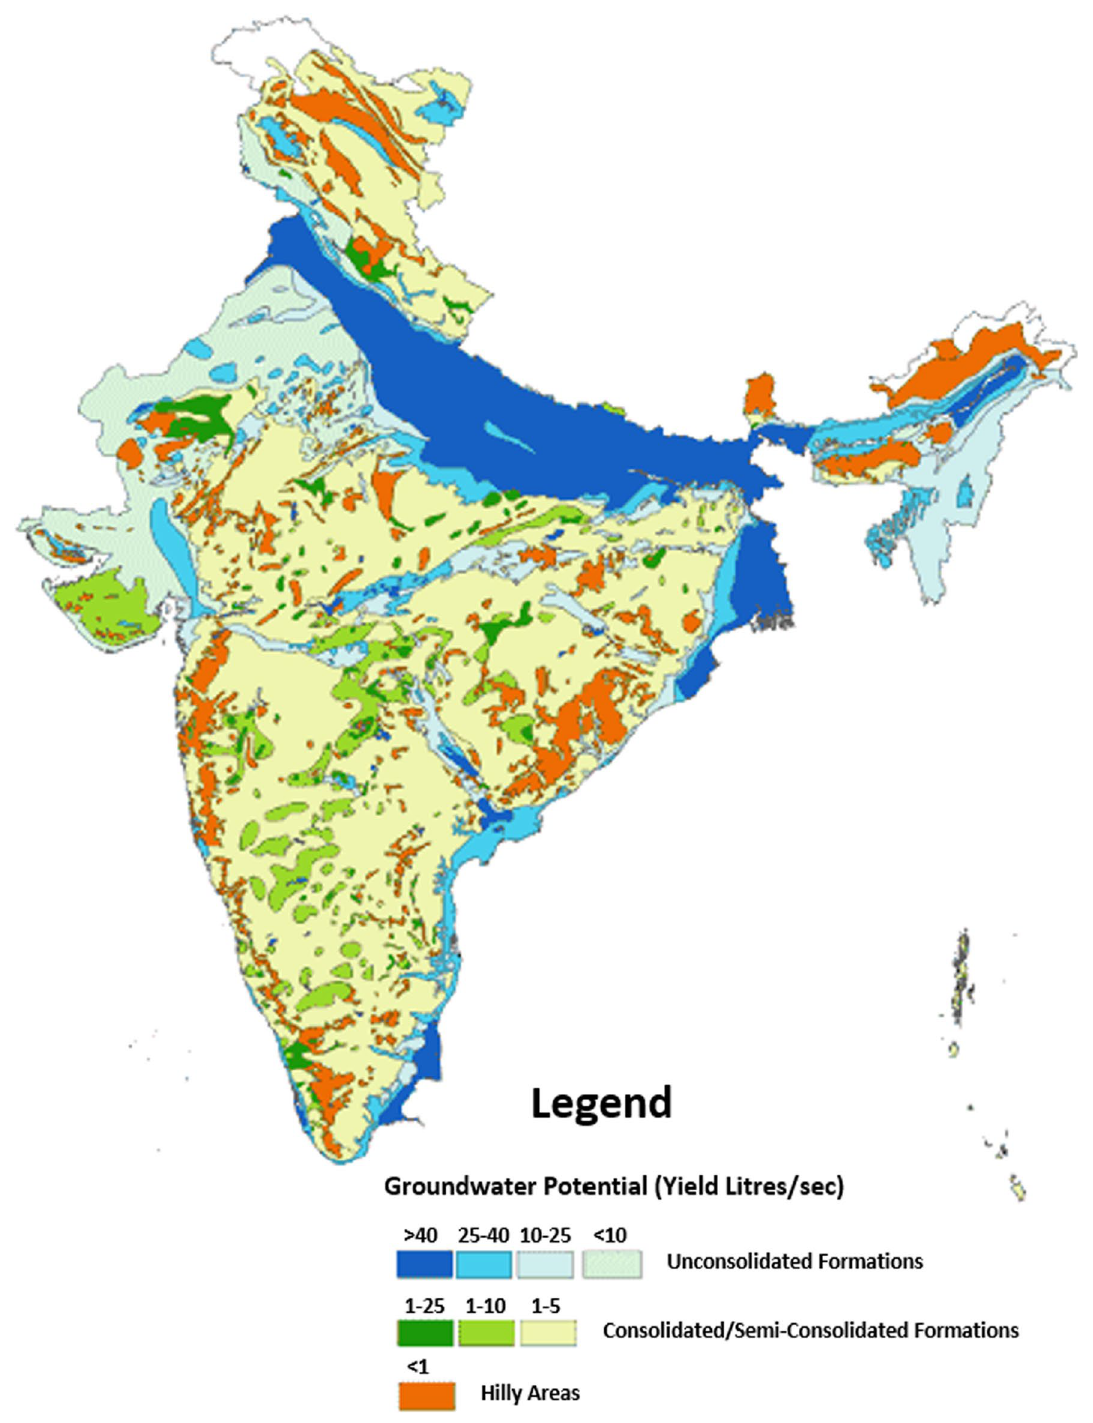
Fig. 3 Hydrogeological map of India ( Source http:// cgwb. gov.